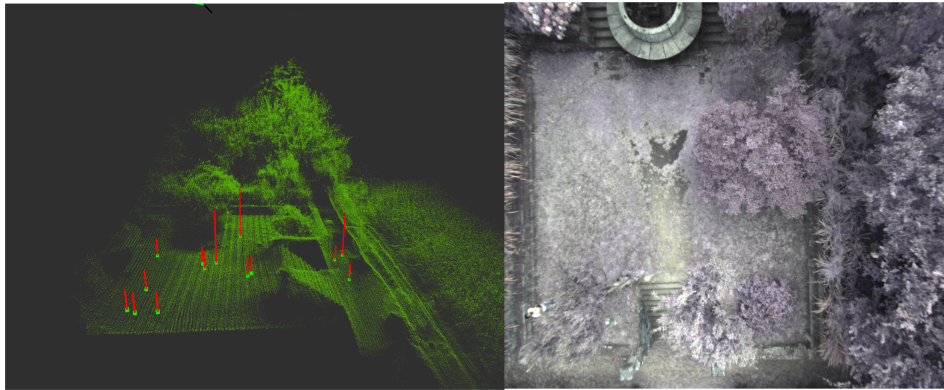
Figure 14. Point cloud, spots, and camera image near a water fountain.